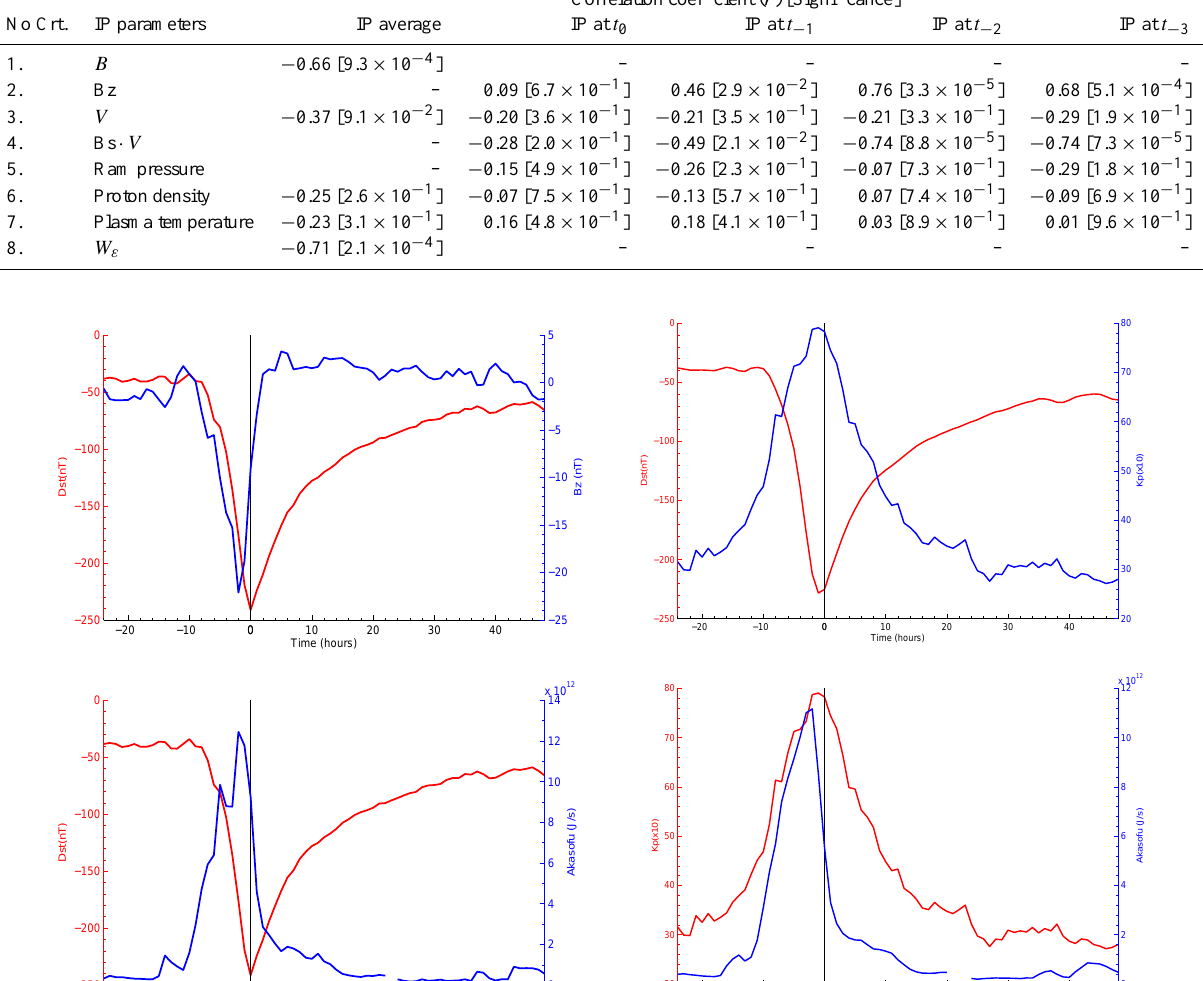
Table 4. The correlation and significance between the interplanetary structures parameters and the minimum value of Dst. The interplanetary parameters are calculated at the same time as the Dst minimum ( t 0 ), one hour ( t − 1 ), two ( t − 2 ) and three hours earlier, respectively. Correlation coefficient ( r ) [Significance] No Crt.